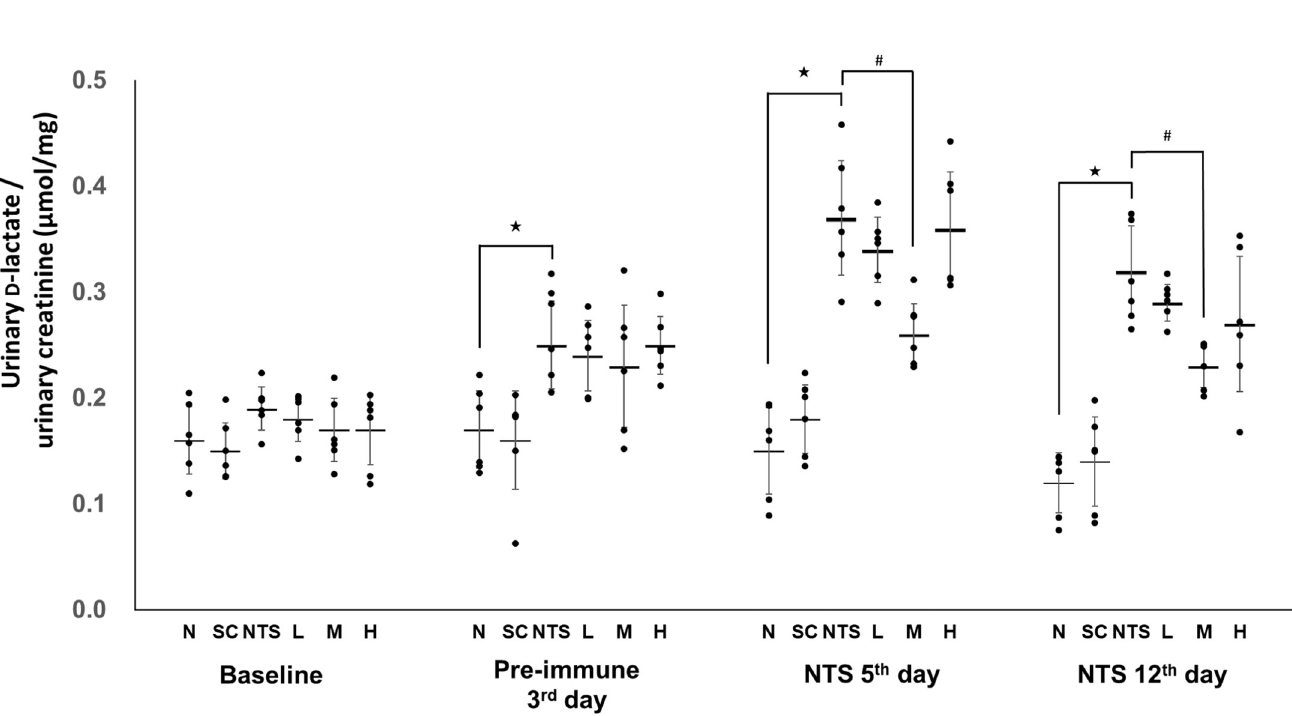
Fig 9. Urinary D-lactate levels in different experimental groups. N: normal group, SC: saikosaponin C control group, NTS: nephrotoxic serum control group, L: SSC 5 mg/kg/day treatment group, M: SSC 10 mg/kg/day treatment group, H: SSC 20 mg/kg/day treatment group. $ p < 0.05 compared to normal group, # p < 0.05 compared to NTS control